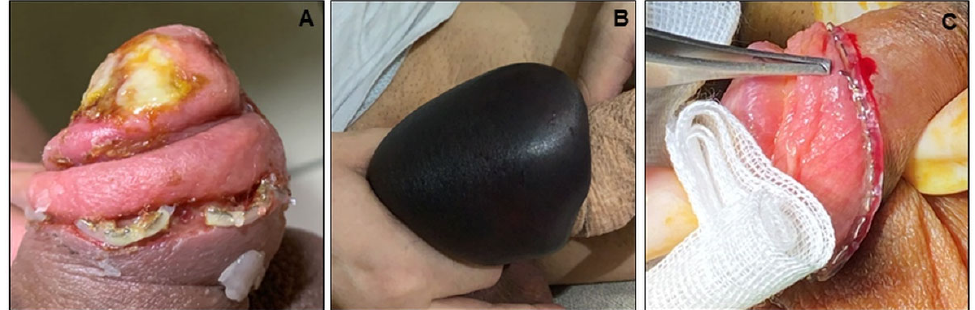
Figure 2. Representative photomicrographs of ( A ) infection, ( B ) hematoma, and ( C ) instrument malfunction.